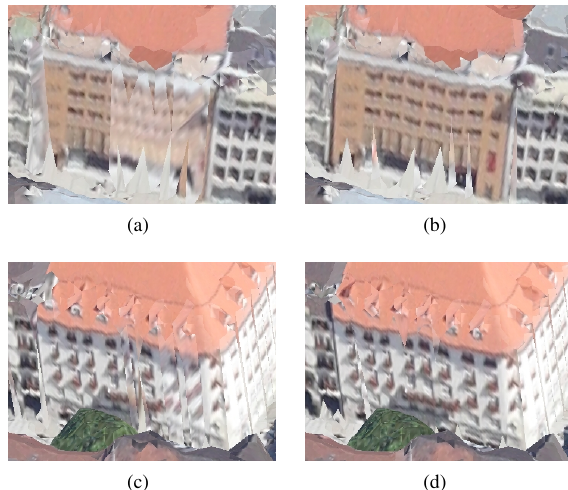
Figure 8. Selected areas of the textured city model with λ = 0.5 (using the α -expansion algorithm). (a) T = 0; (b) T = 0.1; (c) T = 0; (d) T = 0.1